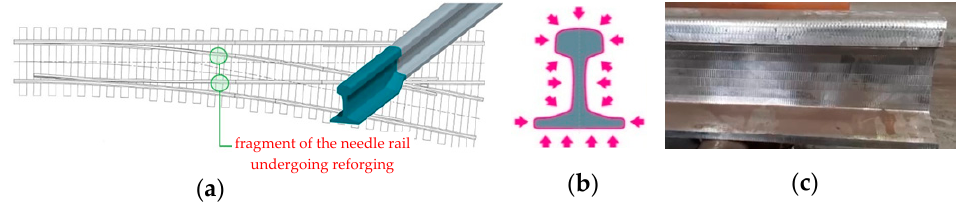
Figure 1. View of ( a ) a fragment of a railroad turnout with the marked needle rails subjected to forging, ( b ) a CAD model with the marked surfaces of the cross section necessary for the mechanical treatment, and ( c ) an image of a mechanically treated reforged needle rail as a result of the previous underdeveloped die forging